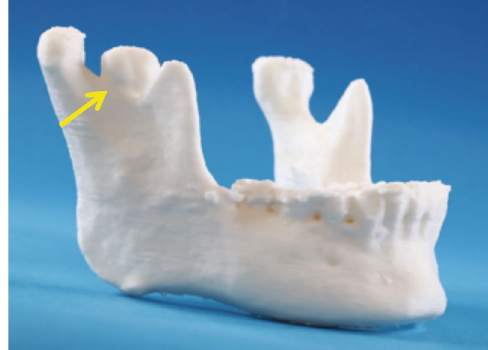
Figure 3: Three-dimensional model of the mandible. We created a three-dimensional model of the mandible to facilitate an explanation to the patient resection surgery using an intraoral approach was